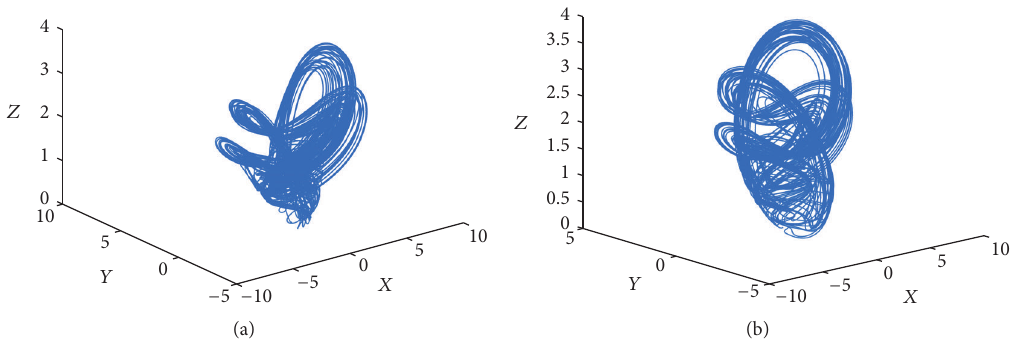
Figure 13: Chaotic tridimensional attractors generated by the proposed system. Initial conditions: (0.1, 0.1, 0.1, 0.1) . Parameters: (a) {𝑎 = 40 and 𝑑 = 2} and (b) {𝑎 = 43 and 𝑑 = 2} .